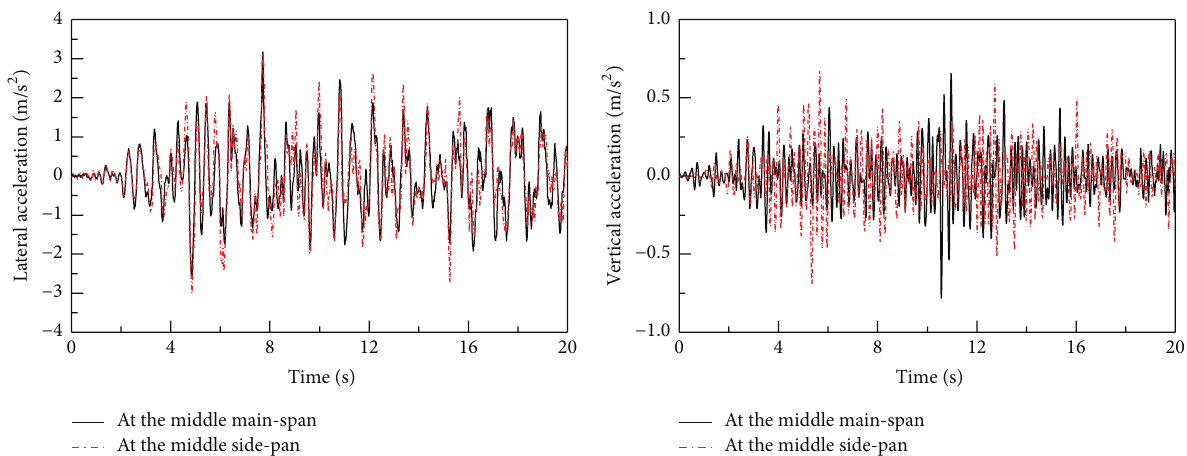
Figure 11: Time histories of lateral and vertical acceleration of the bridge.